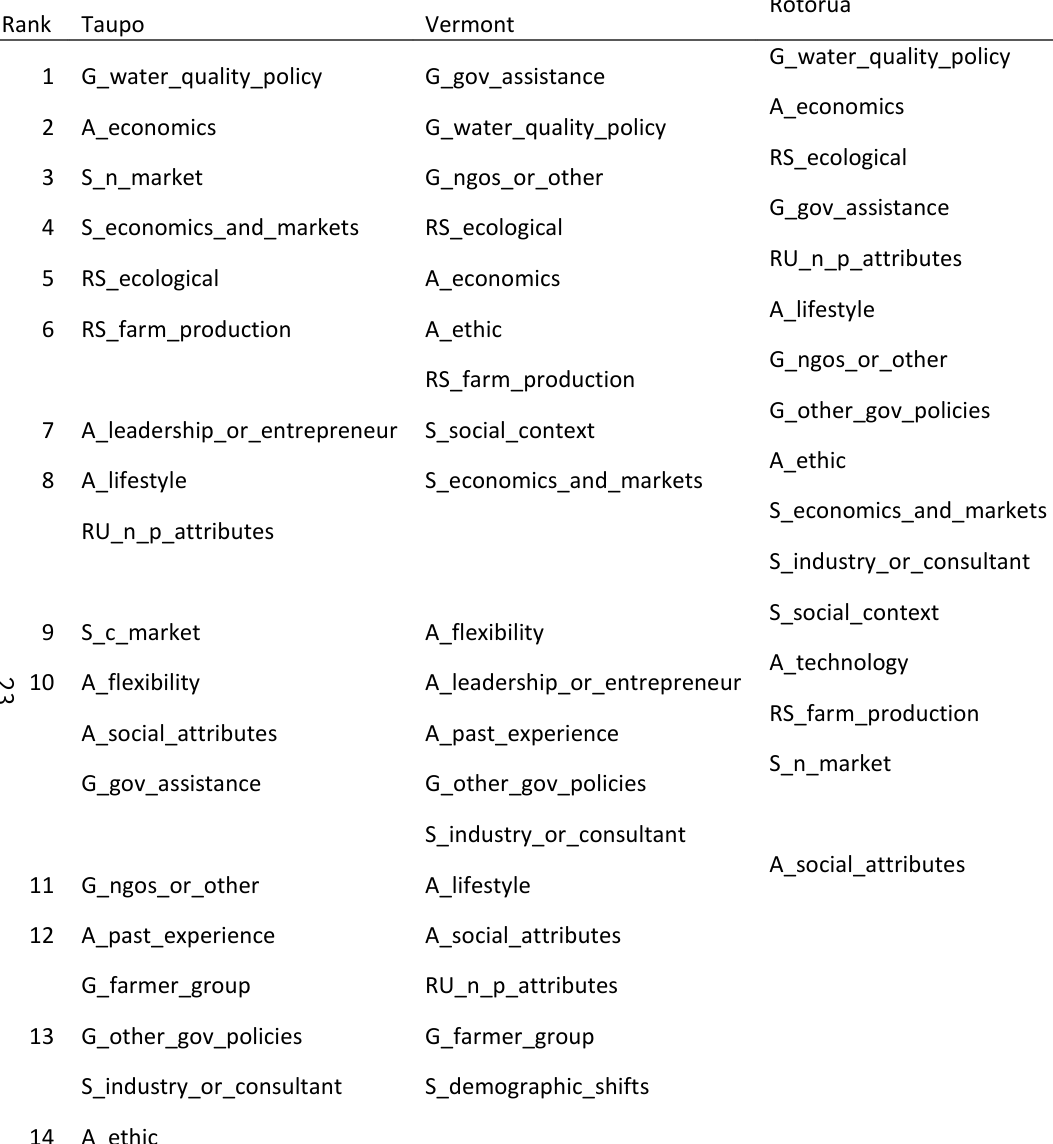
Table A1.4. Drivers ranked by strength across each region. Note that data driving these ranks is from the Driver- behavior sub-network so ranks do not reflect influence on outcomes. The one letter prefix of the driver sub- category node name represents the overall driver category that the node belongs